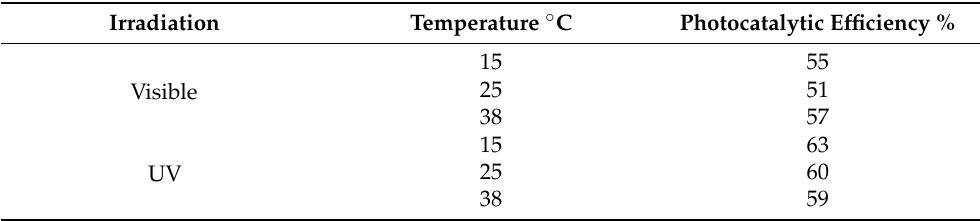
Table 6. Effect of temperature. Tests carried out with TiO 2 :SiO 2 -coated SP samples, under both UV and visible LEDs.